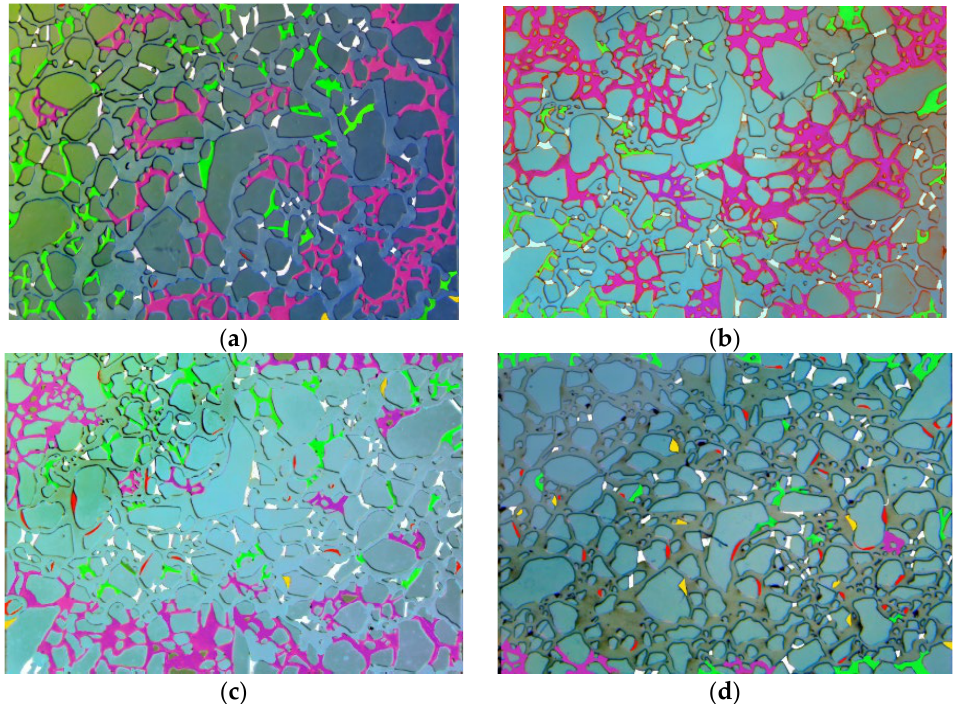
Figure 12. Occurrence state of remaining oil after different soaking pressures: ( a ) 10 MPa; ( b ) 15 MPa; ( c ) 25 MPa; ( d ) 35 MPa.